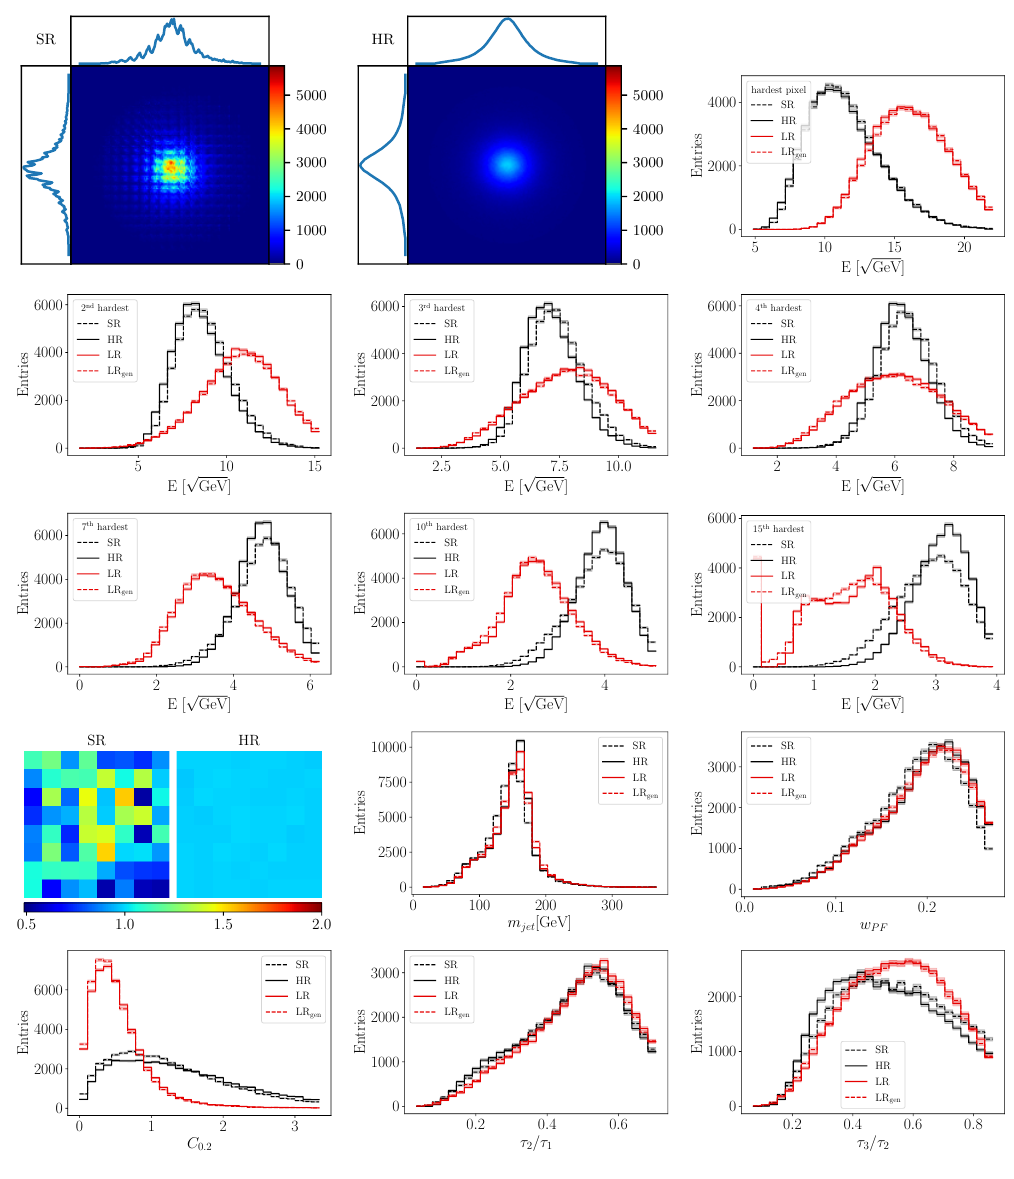
Figure 8: Demonstration of the performance of a network trained on QCD jets and applied to top-quark jets. Top left are averages of the HR and SR images, followed by distributions of the square-root of the energy of leading pixels, sub-leading, etc. Also shown are average ( f × f )-patches for the SR and the HR images, and distributions of high-level jet observables, see text for definitions. The zero-bin in energy collects jets with too few